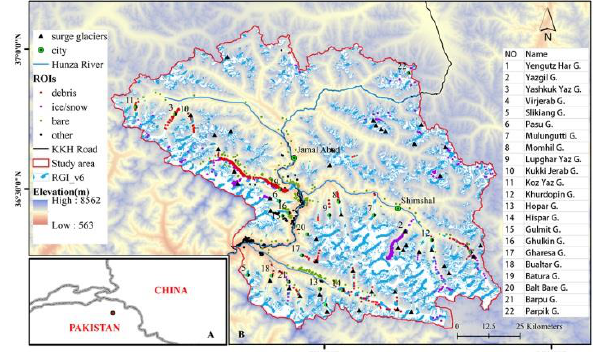
Figure 1. The geographical location of the Hunza Valley with region of interest (ROI) sample sites of various